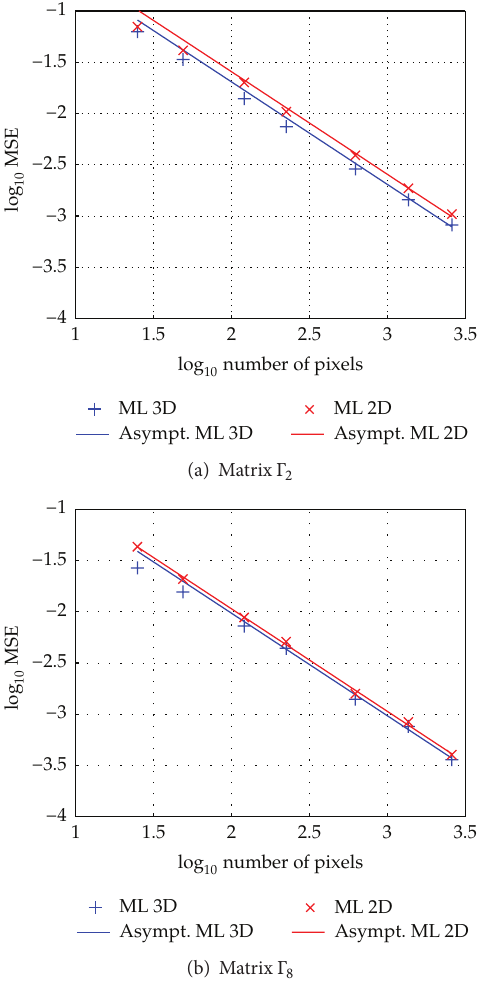
Figure 1: log MSEs of the square DoP estimates using 2 and 3 images versus 𝑃 2 for the set of polarization matrices defined in Table 1 under (a) low flux and (b) high flux assumptions ( 𝑛 = 51 × 51 , ML: maximum likelihood estimators, and Asympt.: theoretical asymptotic value of the log MSE for a given estimator).